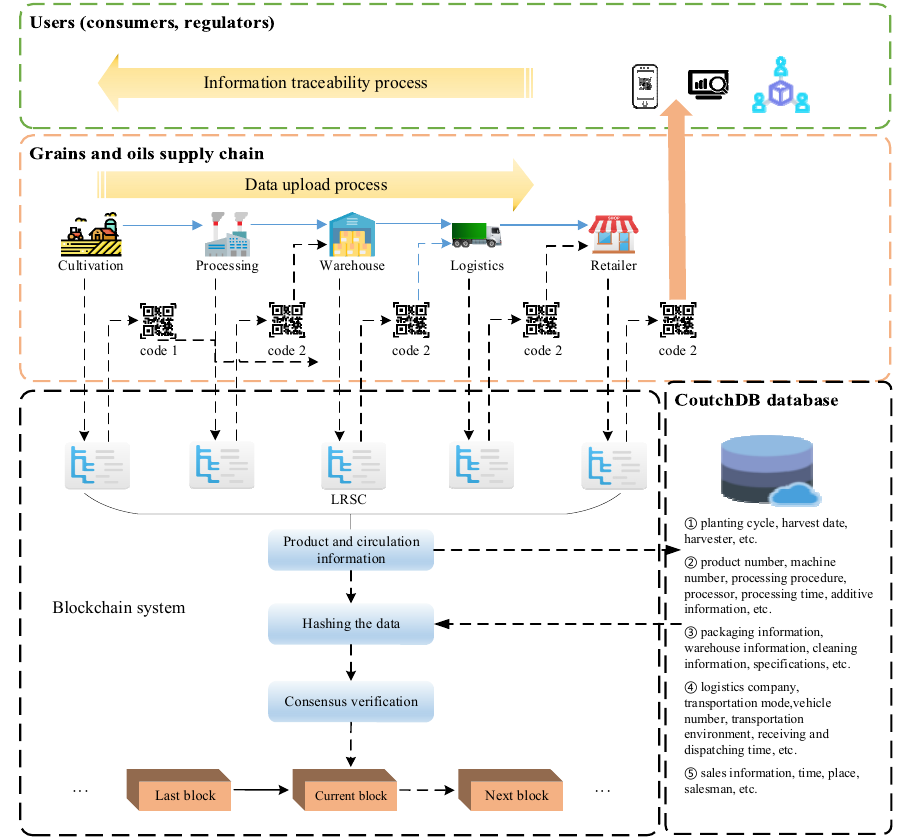
Figure 6. Credible traceability mechanism of the whole supply chain of grain and oil food.